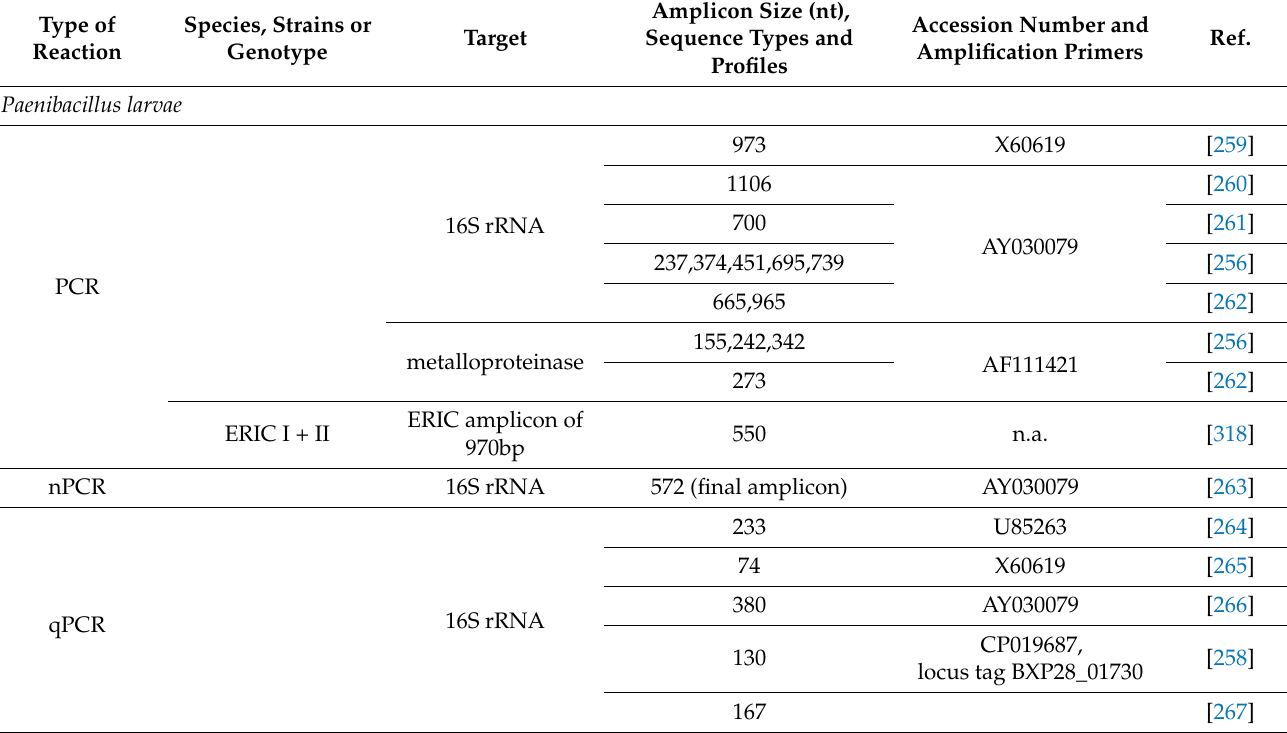
Table 4. Molecular assays for the detection, interspecific differentiation and intraspecific genotyping of bacterial pathogens of the